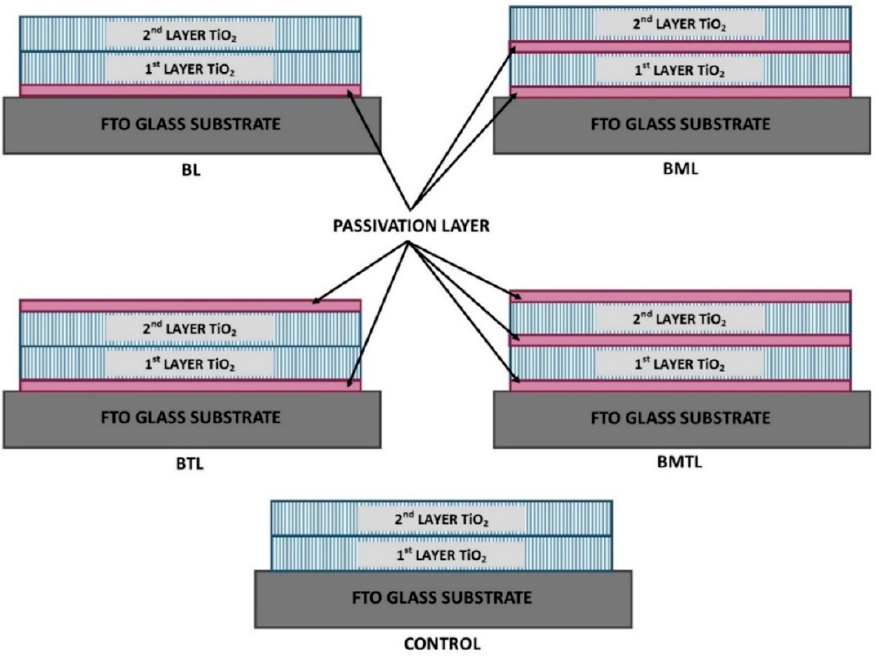
Figure 1. Illustration of the configuration of the prepared photoelectrode samples.